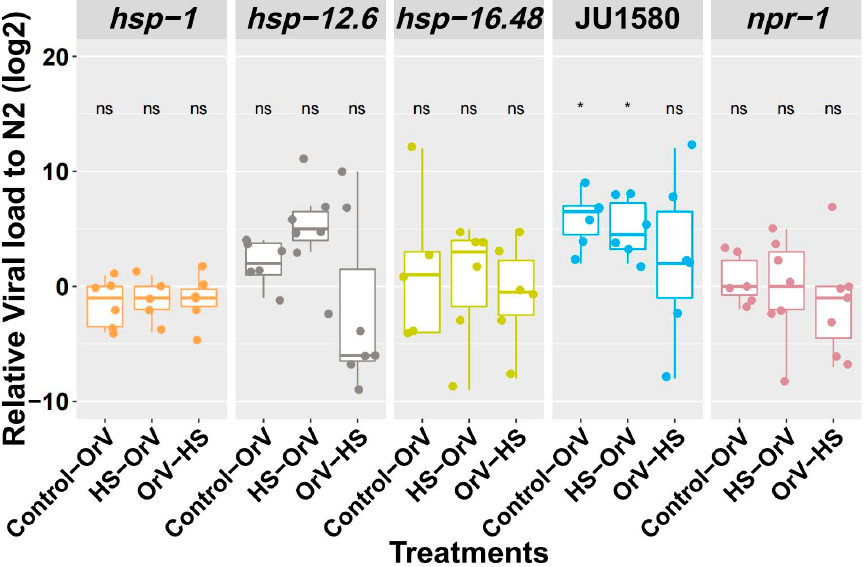
Figure 5. Viral load detection on JU1580 and mutants of hsp-1, npr-1, hsp-12.6, and hsp-16.48 . The y axis represents the viral load difference from N2 within the same batch. Dots: infected biological replicates (each dot is a biological replicate). Differences with N2 were tested. Tukey HSD test, *: significantly different, p < 0.05.